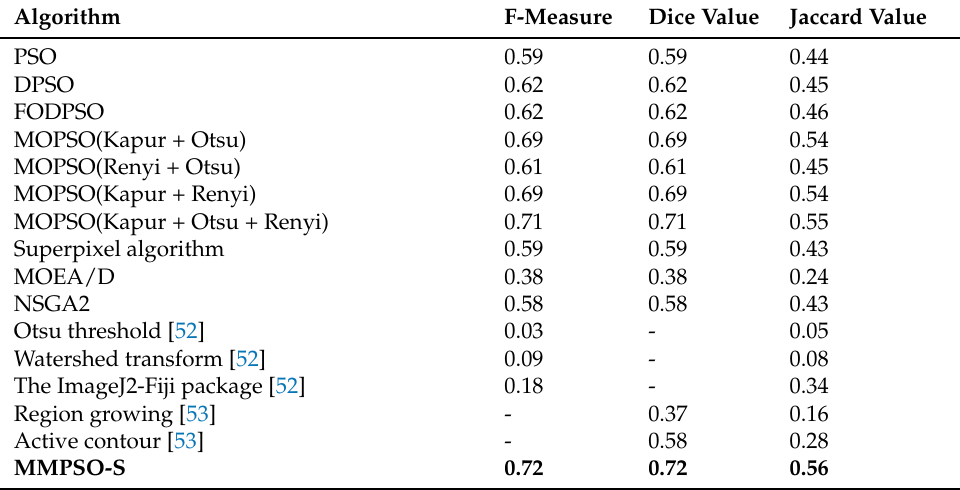
Table 4. Segmentation results of MoNuSeg